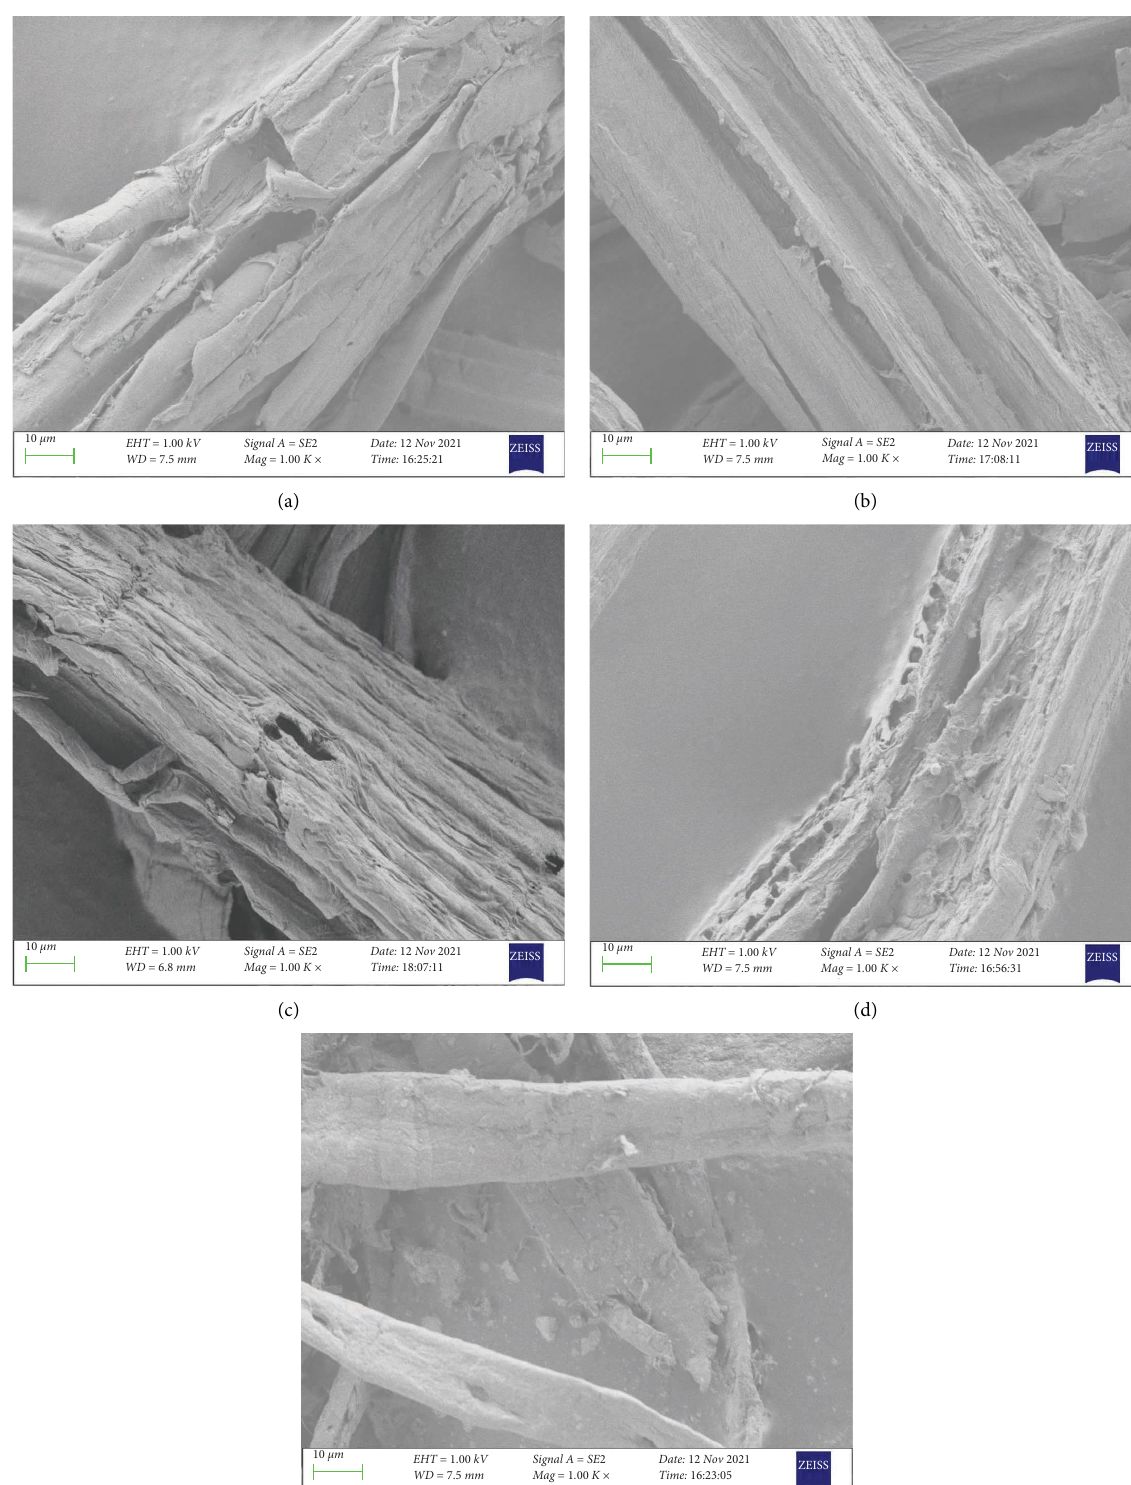
Figure 12: Microscopic view of fber at 1000x. (a) Corn straw fber. (b) Cotton straw fber. (c) Modifed corn straw fber. (d) Modifed cotton straw fber. (e) Lignin